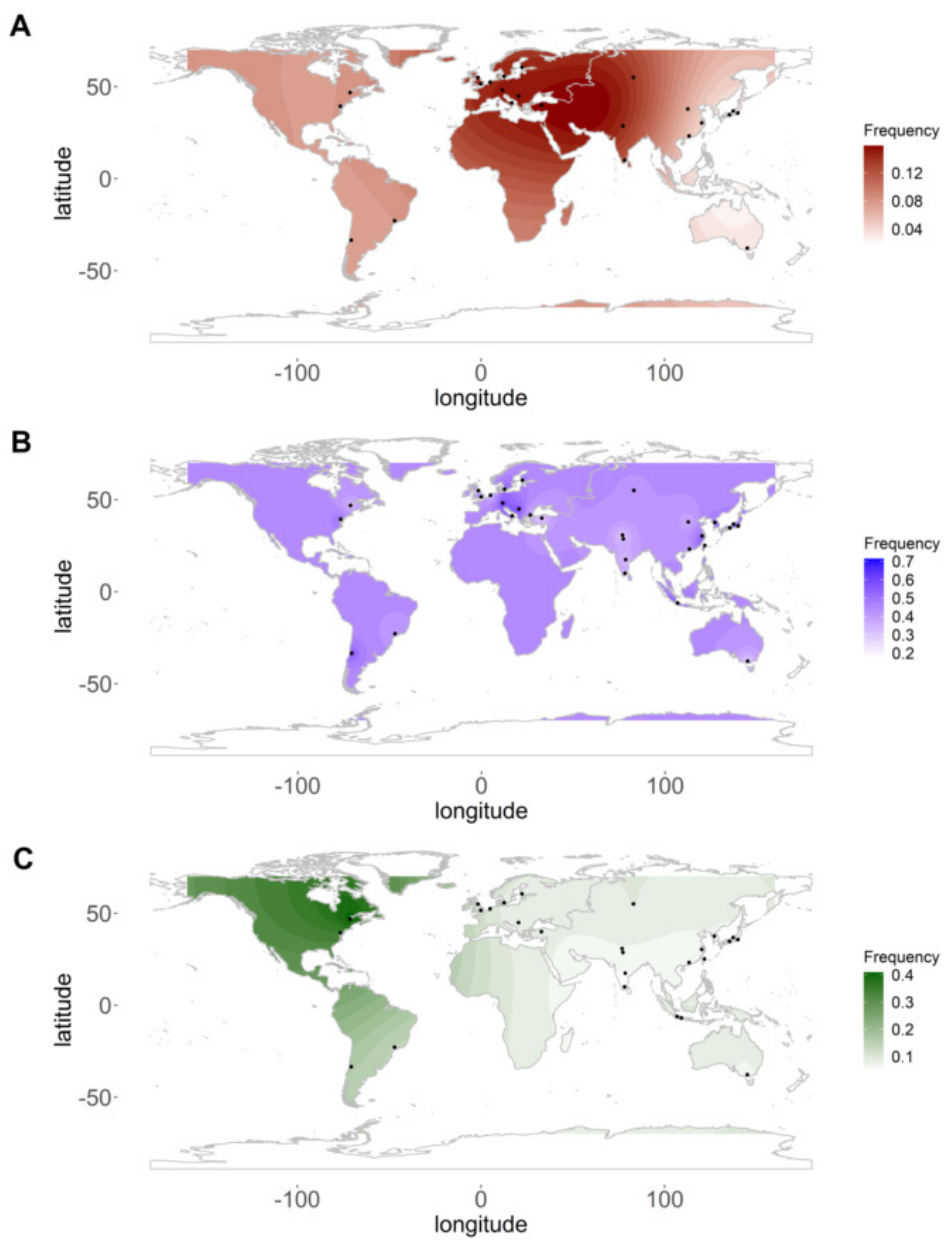
Figure 1. World map showing frequency of primary LHON variants. ( A ) Frequency of m.3460G>A, ( B ) m.11778G>A, and ( C ) m.14484T>C variants. The black dots represent the regions from which samples were included in the publication.